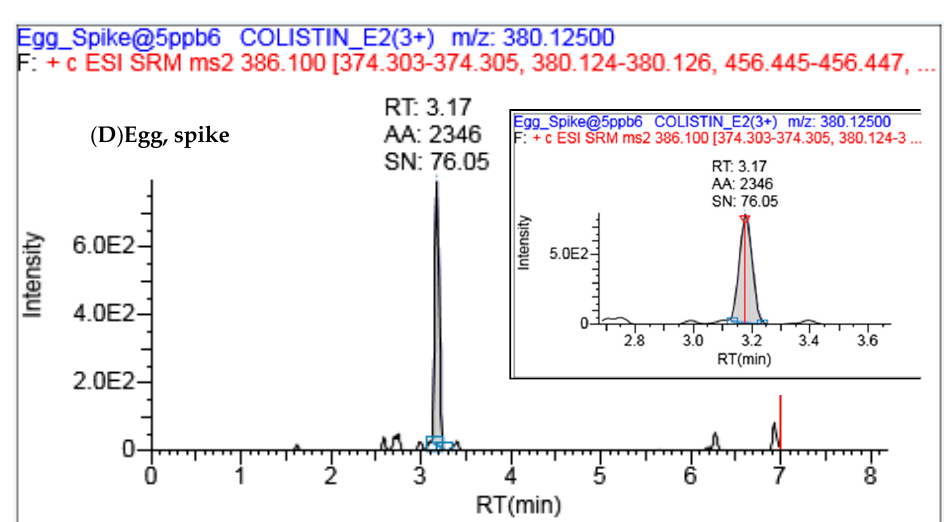
Figure 4. Extracted ion chromatogram (EIC) of colistin B in ( A ) chicken muscle blank, ( B ) 10 µg Kg − 1 spiked muscle, ( C ) egg blank and ( D ) 5 µg Kg − 1 spiked egg.